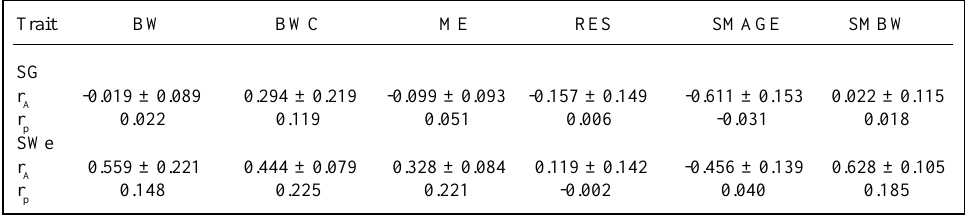
Table IV Genetic correlations (r ) with their standard errors and phenotypic correlations (r A both SG and SWe and various economically important egg traits 1